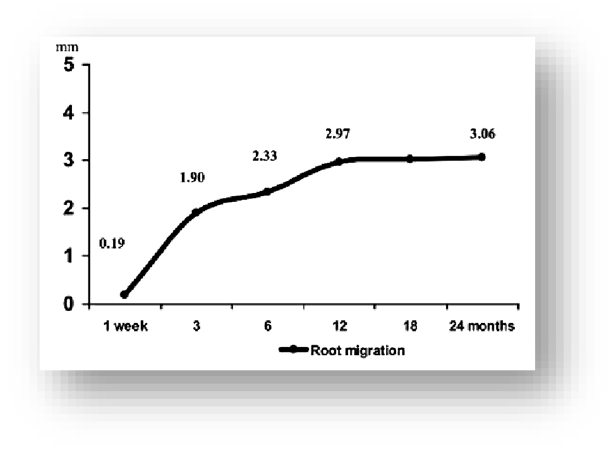
Fig. 7. The roots migration, from Leung et al. (2009)